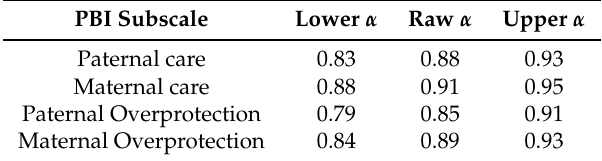
Table 1. Summary of Cronbach’s α for each subscale of the Parental Bonding